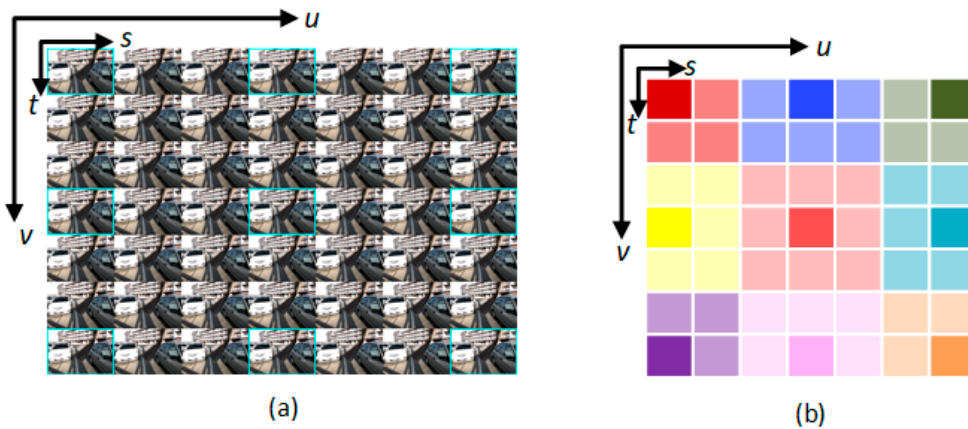
Figure 4. Nearest-view initialization method. ( a ) A 2D array of LF images where 7 × 7 views are to be reconstructed from 3 × 3 views bordered in light blue. ( b ) Input views (shown in bright colors) are used to assign their close neighboring views (shown in light colors) with the same value. After this initialization for all the views to be reconstructed, the raw LF images are created to be used as an input to the network.